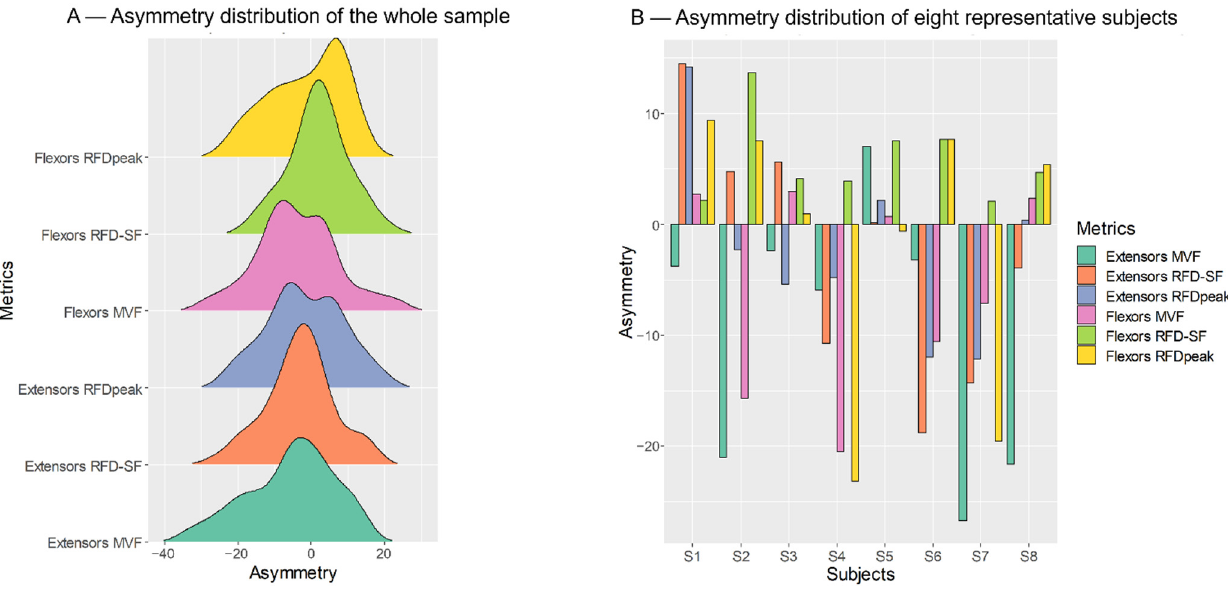
Figure 2. ( A ) Distributions of each performance metric for elbow flexors and extensors. Positive values denote the favour of the dominant limb. As can be seen, the distributions are widely distributed both towards the dominant and non-dominant sides. ( B ) Individual values of bilateral asymmetry indices are reported for each performance metric of the first eight subjects of the sample group. MVF, maximal voluntary force; RFDpeak, peak rate of force development; and RFD-SF (rate of force development scaling